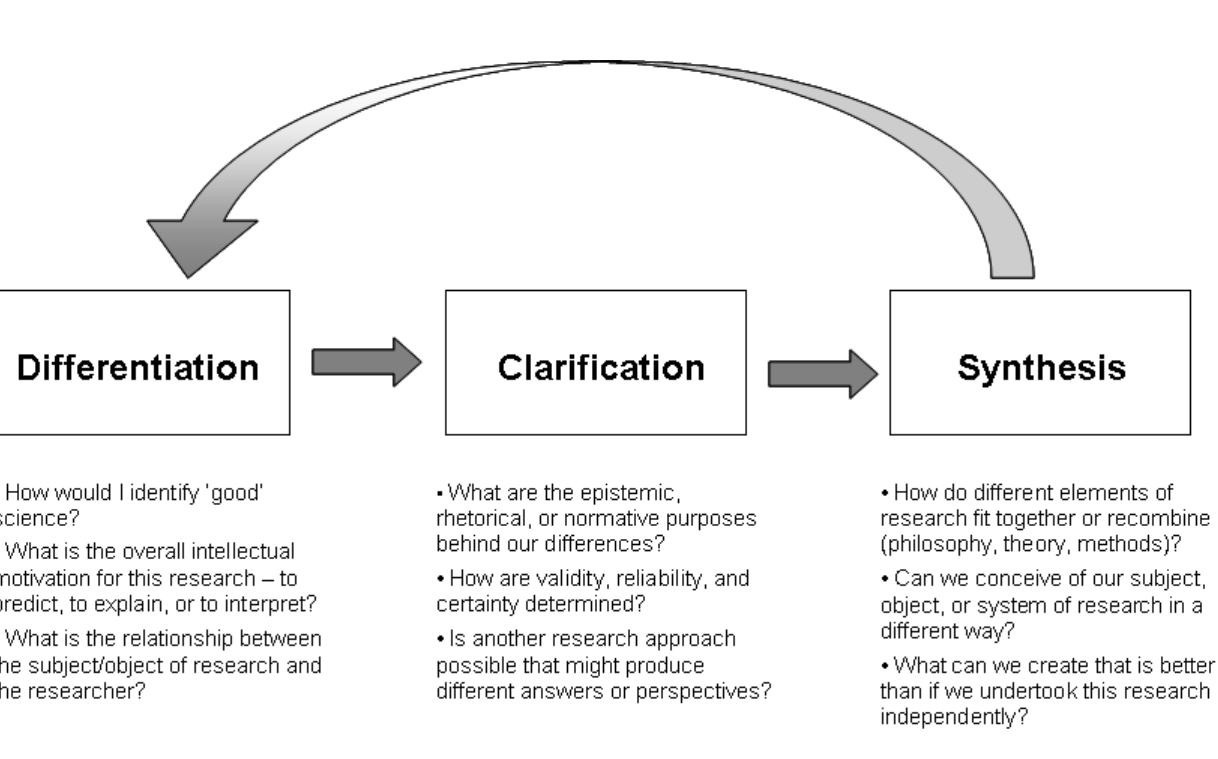
Fig. 2. The process of differentiation, clarification, and synthesis. Key questions at each stage are